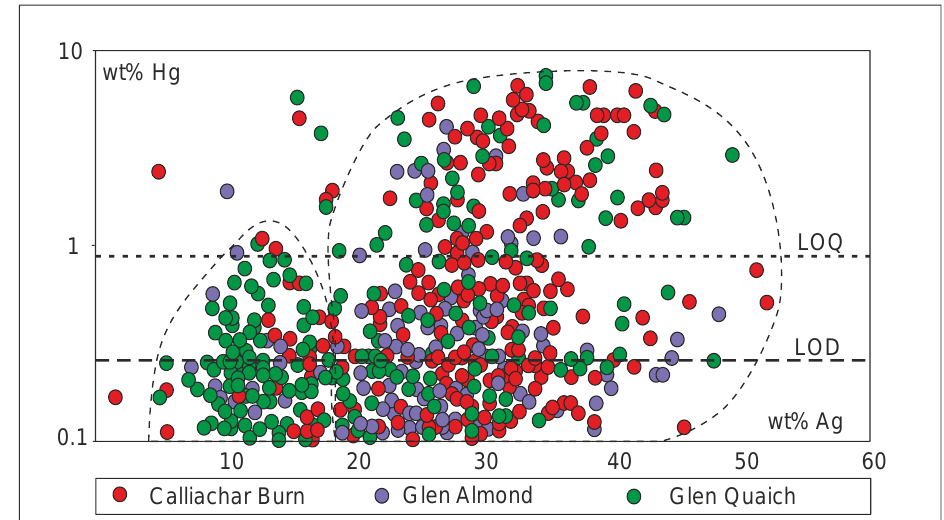
Figure 4. Ag vs. Hg binary plot. Data for gold from Keltie Burn, Sma Glen and Glen Lednock have been omitted as all Hg values are below LOD (Figure 3B). Compositional fields discussed in the text are identified by dashed lines.